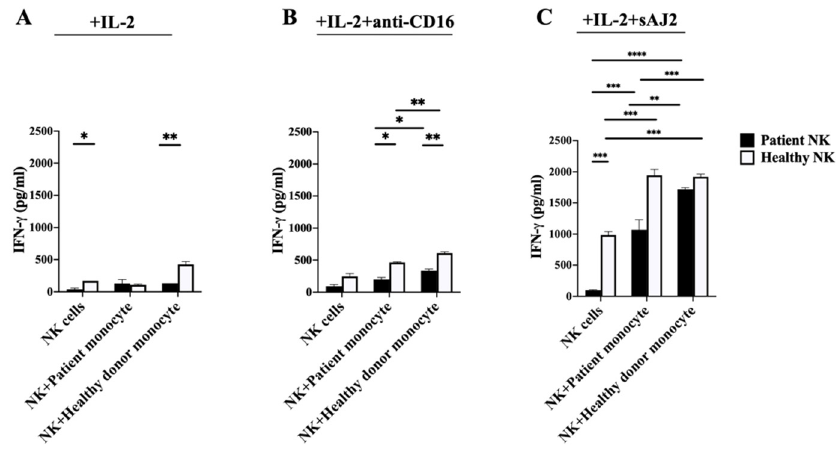
Figure 4. Lower IFN- γ secretion by cancer patients’ NK cells were observed when they were cocultured with autologous or allogeneic healthy monocytes. NK cells and monocytes of cancer patients and those of the healthy individuals were isolated from PBMCs as described in Material and Meth- ods section. NK cells and monocyte were treated with IL-2 (1000 U/mL) alone ( A ), or with a combi- nation of IL-2 (1000 U/mL) and anti-CD16 mAbs (3 µg/mL) ( B ), or with a combination of IL-2 (1000 U/mL) and sAJ2 (NK cells:sAJ2, 1:2) ( C ). Co-cultures of NK cells with autologous and allogeneic monocytes from both the patient and healthy donor were performed. After 18 h of coculture, super- natants were harvested and used in ELISA to measure IFN- γ secretion. A representative experiment is shown, and data are presented as Mean ± SD. Student t tests were performed to determine statis- tical significance. **** ( p value < 0.0001), *** ( p value < 0.001), ** ( p value 0.001–0.01), * ( p value 0.01– 0.05). 3.5. Cancer Patients’ NK Cells when Cocultured with Healthy Monocytes and Treated with sAJ2 Induced Higher IFN- γ and Elevated Surface Receptor Expressions Associated with the Differen- tiation of Tumor Cells As previously described, NK cells play important roles in differentiating CSCs, lead- ing to slower tumor growth, and decreased tumor metastasis [26,46]. Therefore, we cocul- tured autologous and allogeneic NK and monocytes and used their supernatants to dif- ferentiate OSCSCs. The surface expressions of CD54 and MHC-class I were determined on the surface of oral tumors three days after treatment with the supernatants. We ob- served higher surface expression of CD54 (Figures 5A and S4A), and MHC-class I (Figures 5B and S4B), when cocultures were treated with IL-2 + sAJ2 in comparison to IL-2 alone or IL-2 + anti-CD16 mAbs. Also, higher surface expressions of CD54 (Figures 5A and S4A), and MHC-class I (Figures 5B and S4B) on tumor cells were found when supernatants from both healthy and patient NK cells cultured with healthy monocytes were used to differ- entiate tumors in comparison to using patient monocytes. Next, we determined the ratios of the density of surface expressions for CD54 and MHC class I (as represented by MFI) in anti-CD16 mAbs or sAJ2 treated NK cells in the presence and absence of autologous and allogeneic monocyte cocultures treated with and without sAJ2 (Figure 5C,D). The fold change in the expression levels between NK cells alone and those cultured with the mon- ocytes when autologous patient NK cells are used in the cocultures after activation with IL-2 and anti-CD16 mAbs (1.16-fold for CD54 expression and 1.2-fold for MHC-class I expression) was much less when compared to that of NK cells and autologous monocyte cocultures from healthy individuals (1.74-fold increase for CD54 and 1.8 for MHC-class I) (Figure 5C,D). Addition of sAJ2 to cocultures highly improved the fold change between NK cells alone and those cultured with monocytes between patients and healthy individ- uals (1.7-fold change for CD54 and 2.2-fold change for MHC-class I expression in patient cocultures vs. 2.0-fold change for those from healthy individuals for CD54 expression, and 1.55-fold change for MHC-class I for those from healthy individuals) (Figure 5C,D). The